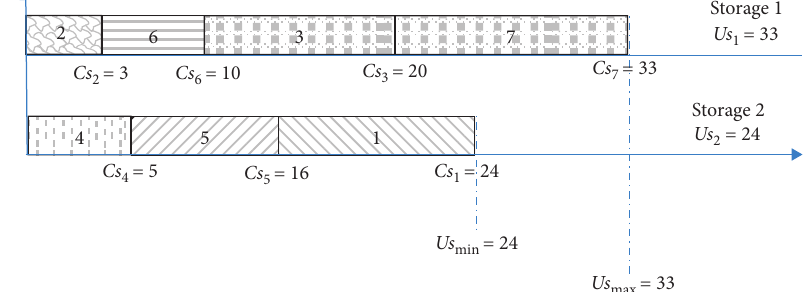
Figure 1: Size file-storages